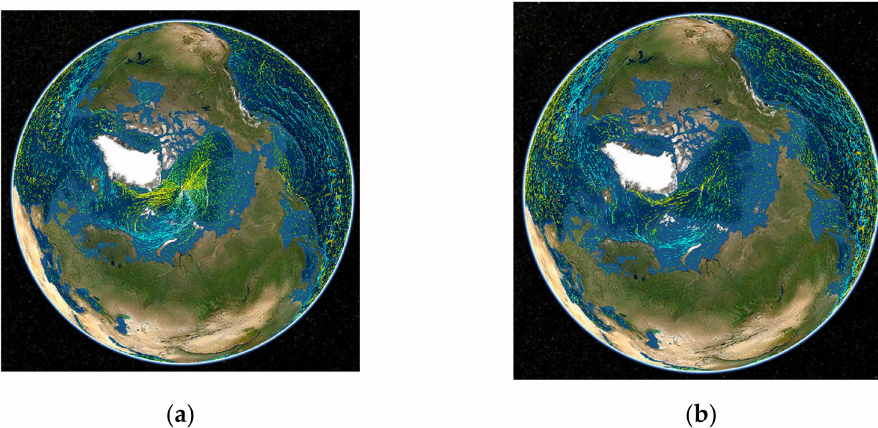
Figure 8. Comparison of Rendering Effect of Flow Field in Arctic Region. ( a ) is the result of using traditional placement method, and ( b ) is the result of using Marsaglia’s